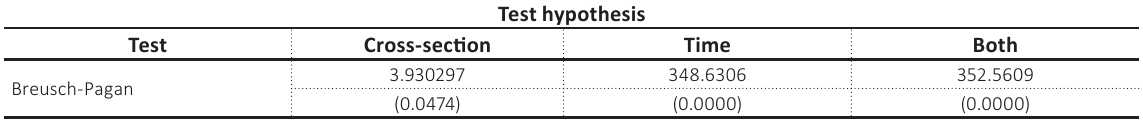
Table A3. Lagrange multiplier test